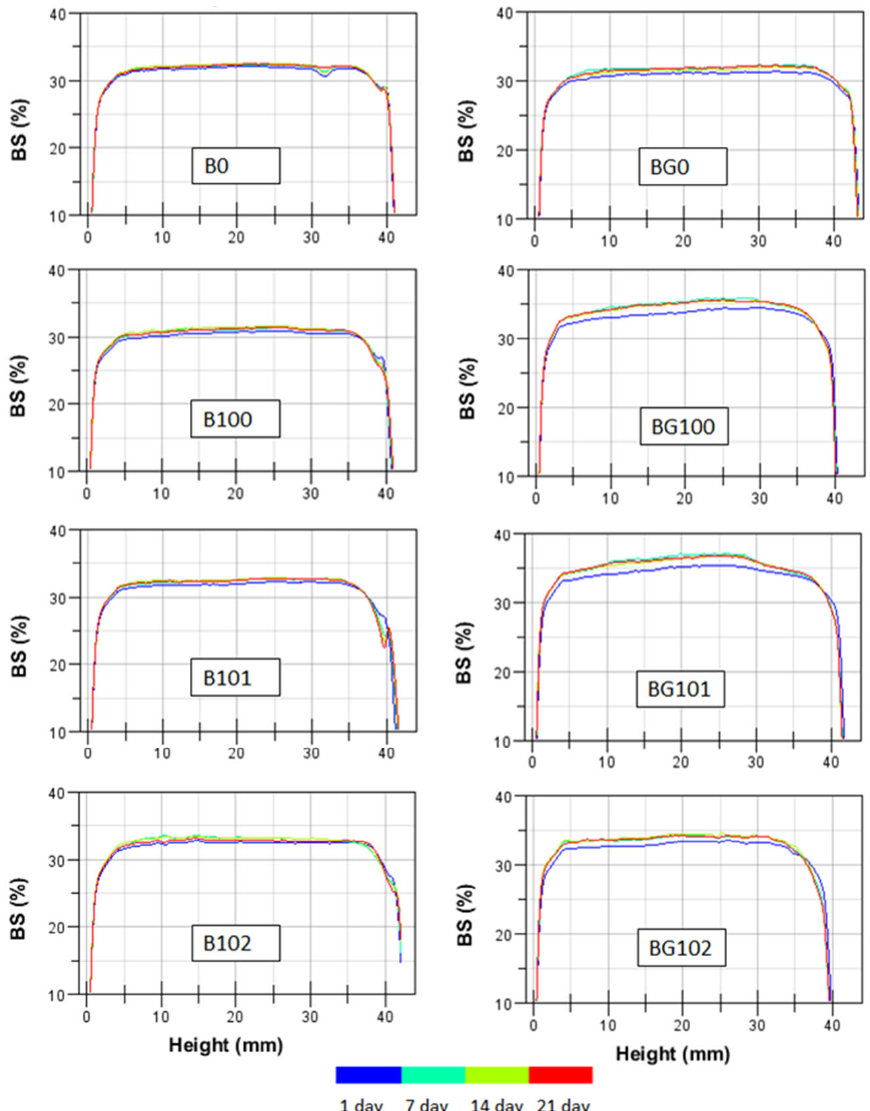
Figure 1. The backscatter (BS) profiles as a function of sample height within 21 days at 6 °C for BBB. Explanations: B/BG0, B/BG100, B/BG101, B/BG102—description as in Table 1.